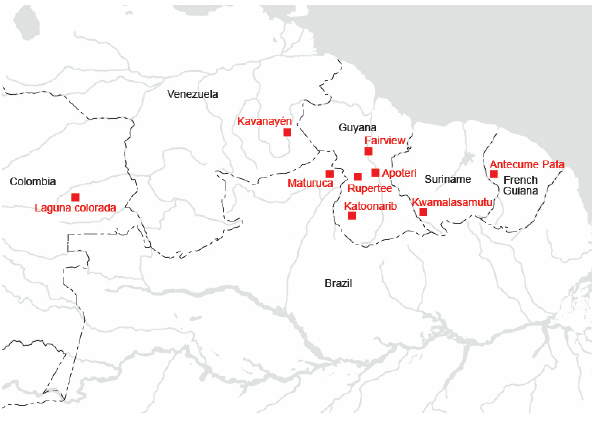
Fig. 1 . Indigenous communities of the Guiana Shield involved in the exchanges. The best practices that formed the basis of the knowledge exchange were developed primarily from the North Rupununi, Guyana, including the communities of Apoteri, Fairview, and Rupertee (Drawing credit: Jenny